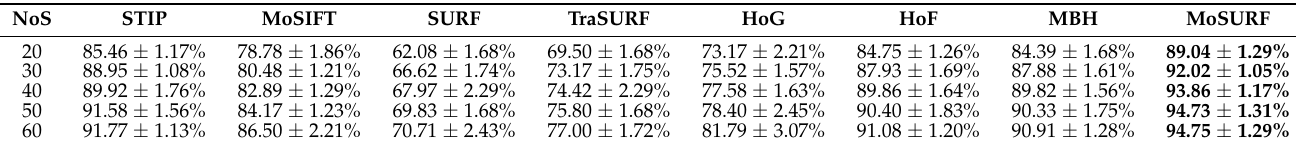
Table 1. Experimental results for different descriptors on KTH.